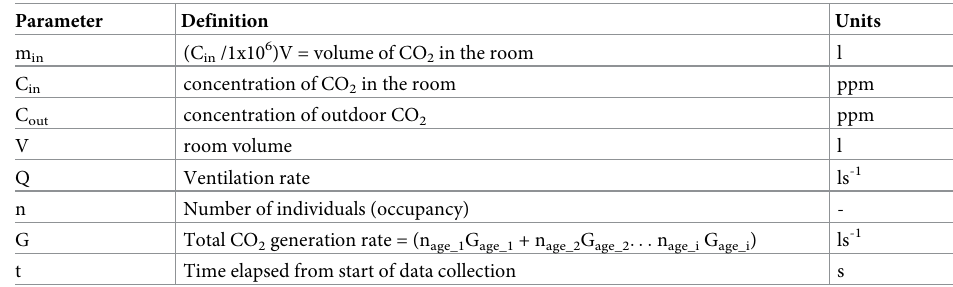
Table 1. Definitions of